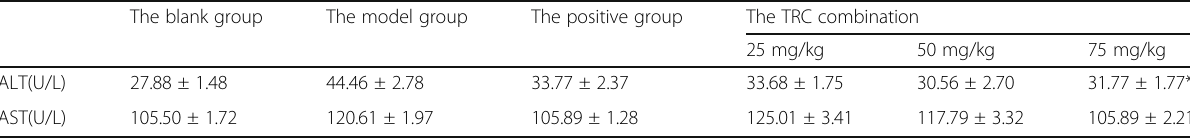
Table 5 The concentration of ALT and AST The blank group The model